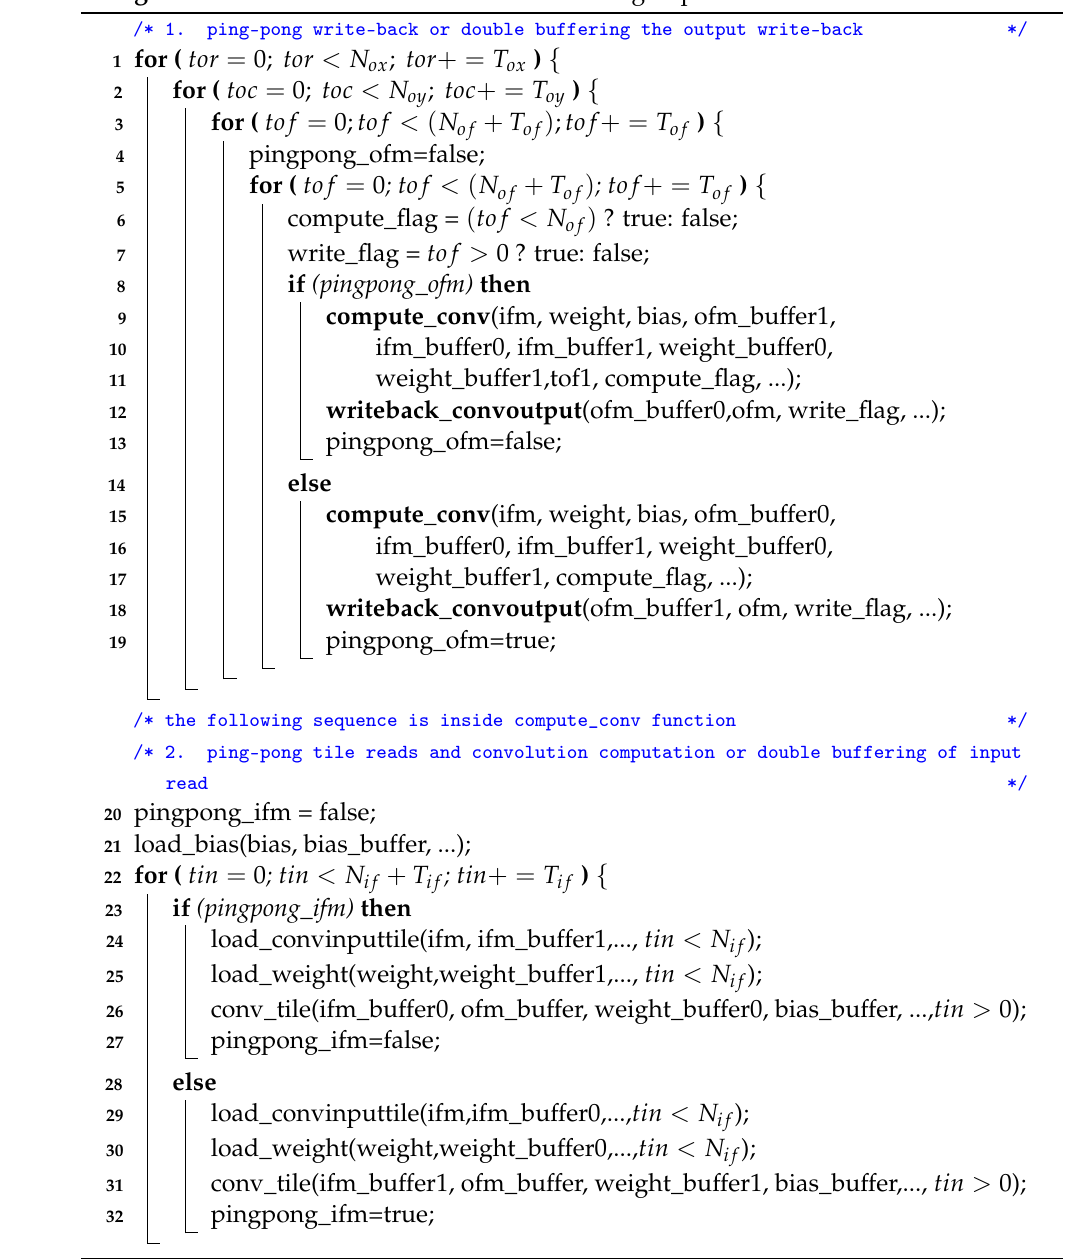
Algorithm 1: Illustration of our double-buffering